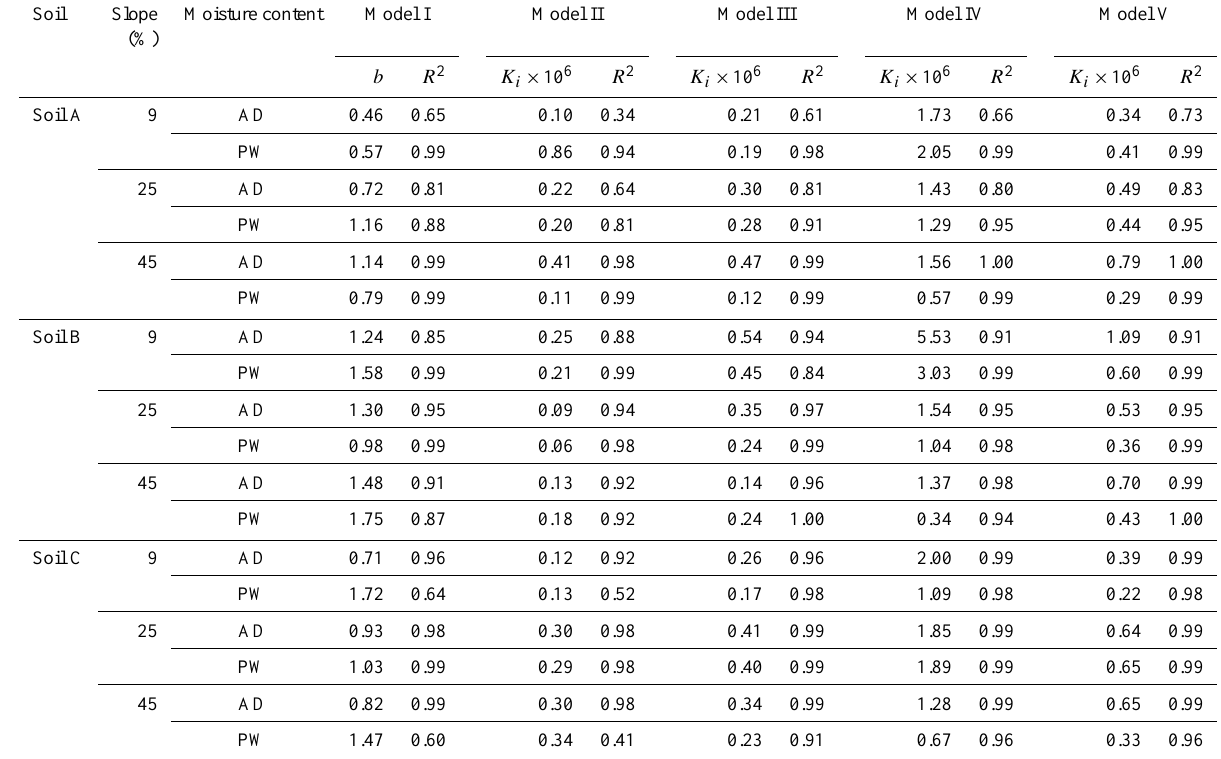
Table 9. Exponents, coefficients, and R 2 values for equations describing interrill soil loss.